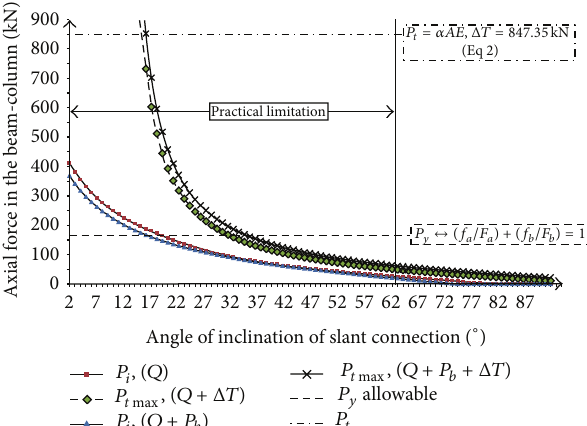
Figure 19: Relation between axial force in the beam with slope of slant connection ( 𝜃 ∘ ) due to nonsymmetric gravity load and elevated temperature (friction factor, 𝜇 𝑠 = tan 𝜑 = 0.2 ) (Δ𝑇) = 50 ∘ C.